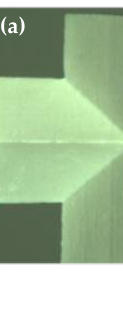
Figure 6. 3D geometries with the proposed system calibration method. ( a , c ) Photographs; ( b , d ) reconstructed geometries. 4. Conclusions We have proposed a polynomial-based calibration method for a telecentric structured light system, which consists of a telecentric camera and a pin-hole projector. The proposed method is divided into axial calibration and transverse calibration. The former needs to build up the relationship between the absolute phase and the depth data. The latter requires establishing the relationship between pixel positions and X, Y coordinates. Compared with the existing methods that need to calibrate the projector, the calibration method proposed in this research for telecentric structured light systems has the following advantages: (1) Accuracy. The proposed method averts the coupling of correspondence errors between camera pixels and projector pixels, hence increasing measurement accuracy. (2) Ease of operation. During the whole calibration process, a calibration plate is fixed on a translation stage and then successively translated along the depth direction. The orientation of the plate does not change, so the proposed calibration method is easy to operate. (3) Simplicity. The proposed calibration method avoids projector calibration, which makes calibration simple. In the proposed method, applying more calibration plate positions can cover the measuring volume better. This can provide a higher calibration accuracy, but increases time consumption to perform projection and capture of fringe patterns. To keep a balance between calibration accuracy and time complexity, the appropriate number of calibration plate position should be chosen for system calibration according to the depth of a measured object. Additionally, a translation stage is required to accurately provide the calibration plate with known depth information to meet the requirement of high accuracy measurement, so the calibration procedure is difficult to perform out of the laboratory environment. Comprehensively considering the pros and cons, we deduce that the proposed method is quite suitable for high-accuracy 3D measurements of small-scale objects [22] and has great potential in 3D shape measurement of micro-parts with a size on the order of millimeters, used in micro-parts mechanical system (MEMS)